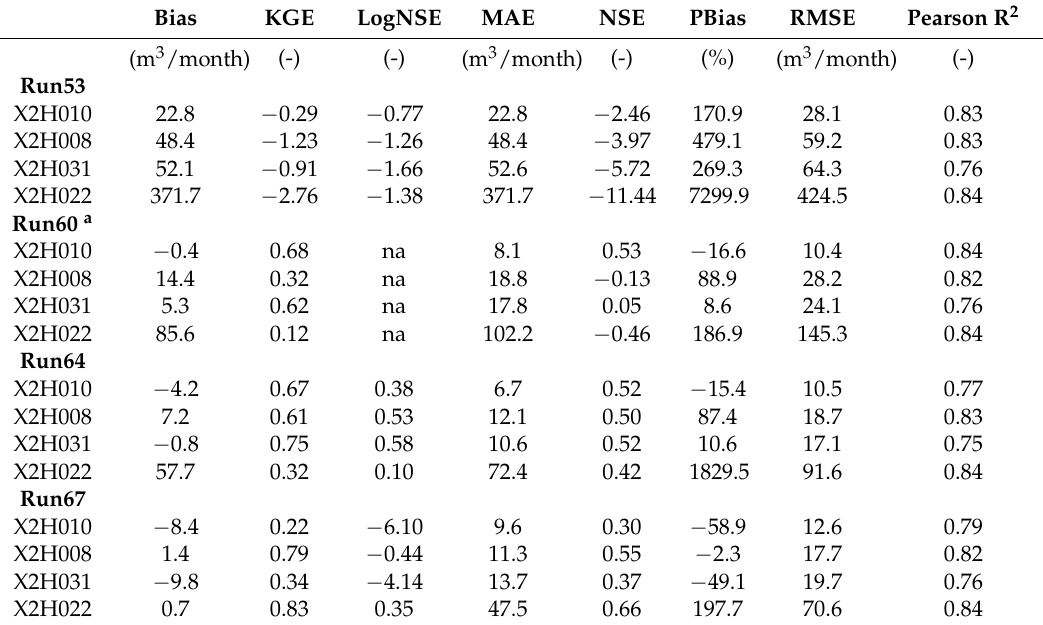
Table 5. Goodness of fit indicators for the selected model runs, at monthly time